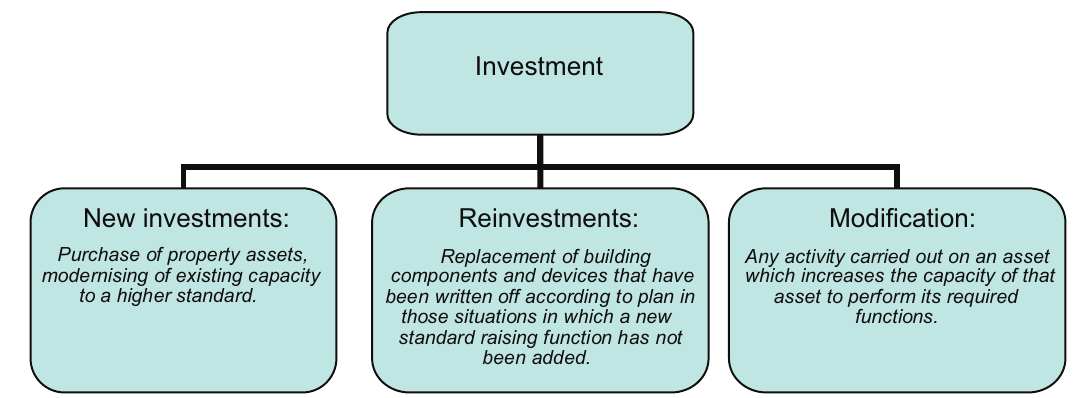
figure 2. Investment types in aff